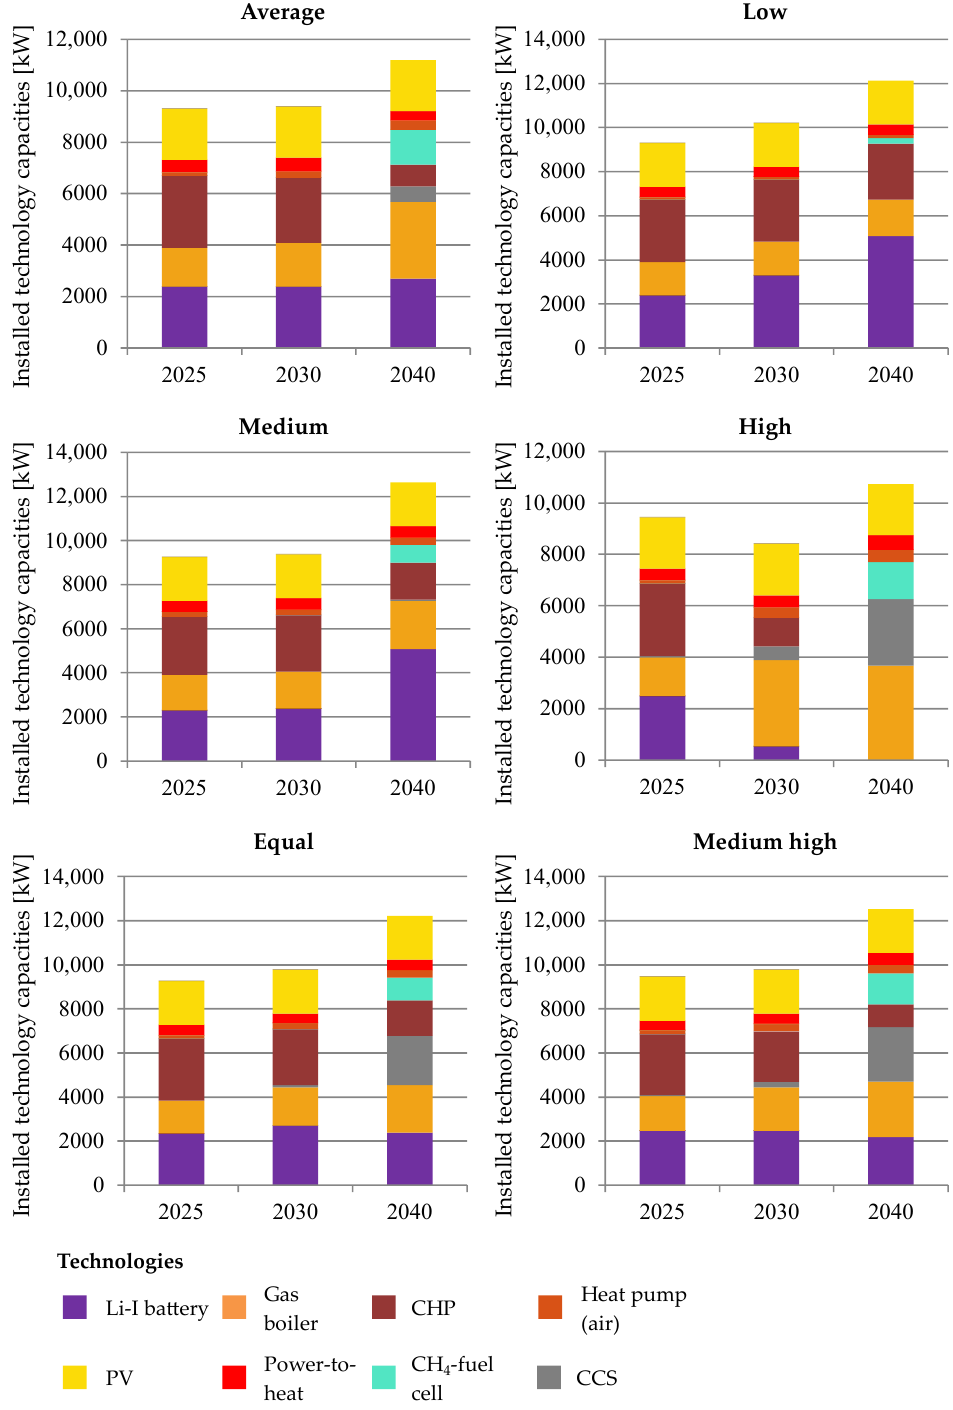
Figure 9. Installed technologies for different scenarios with uncertain CO 2 prices (myopic, with CCS).